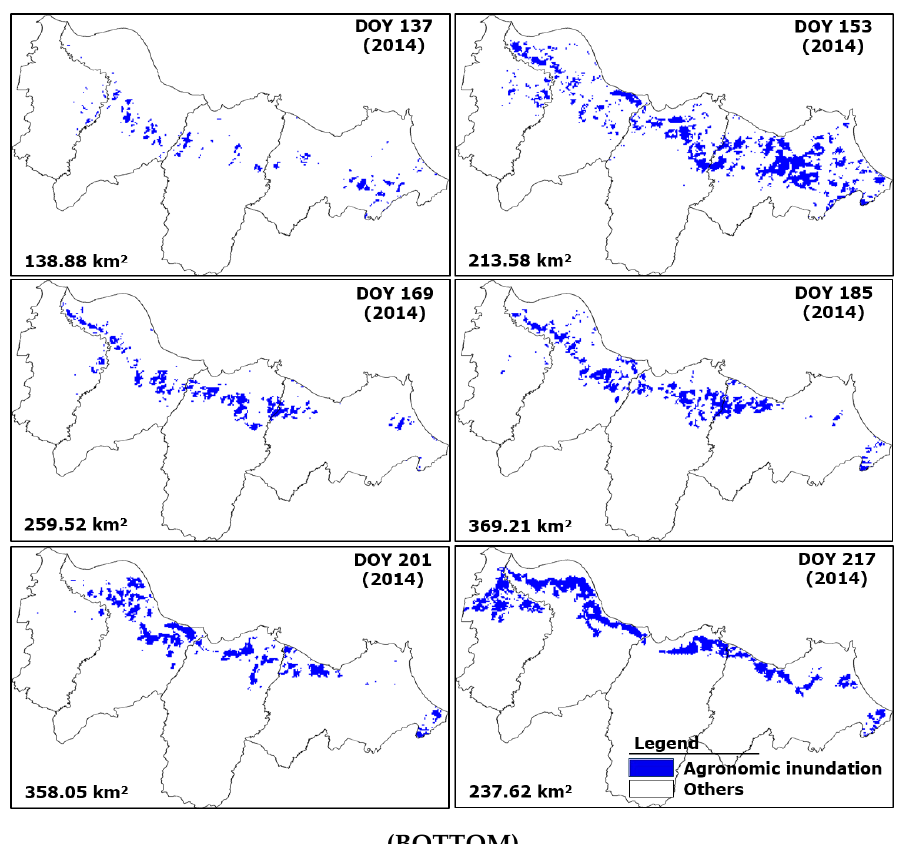
Figure 2. Time series of surface water maps generated using EVI ≤ 0.1 in irrigated rice fields in West Java. ( Top ) wet planting season: DOY 337 (2013)–49 (2014). Surface water comprises both hazardous flooding and non-hazardous agronomic inundation. ( Bottom ) dry planting seasons DOY 137–217 (2014). Value at the left corner of each figure is the surface water area in km2. Rice field areas presented in Figure 1 is used as a mask.